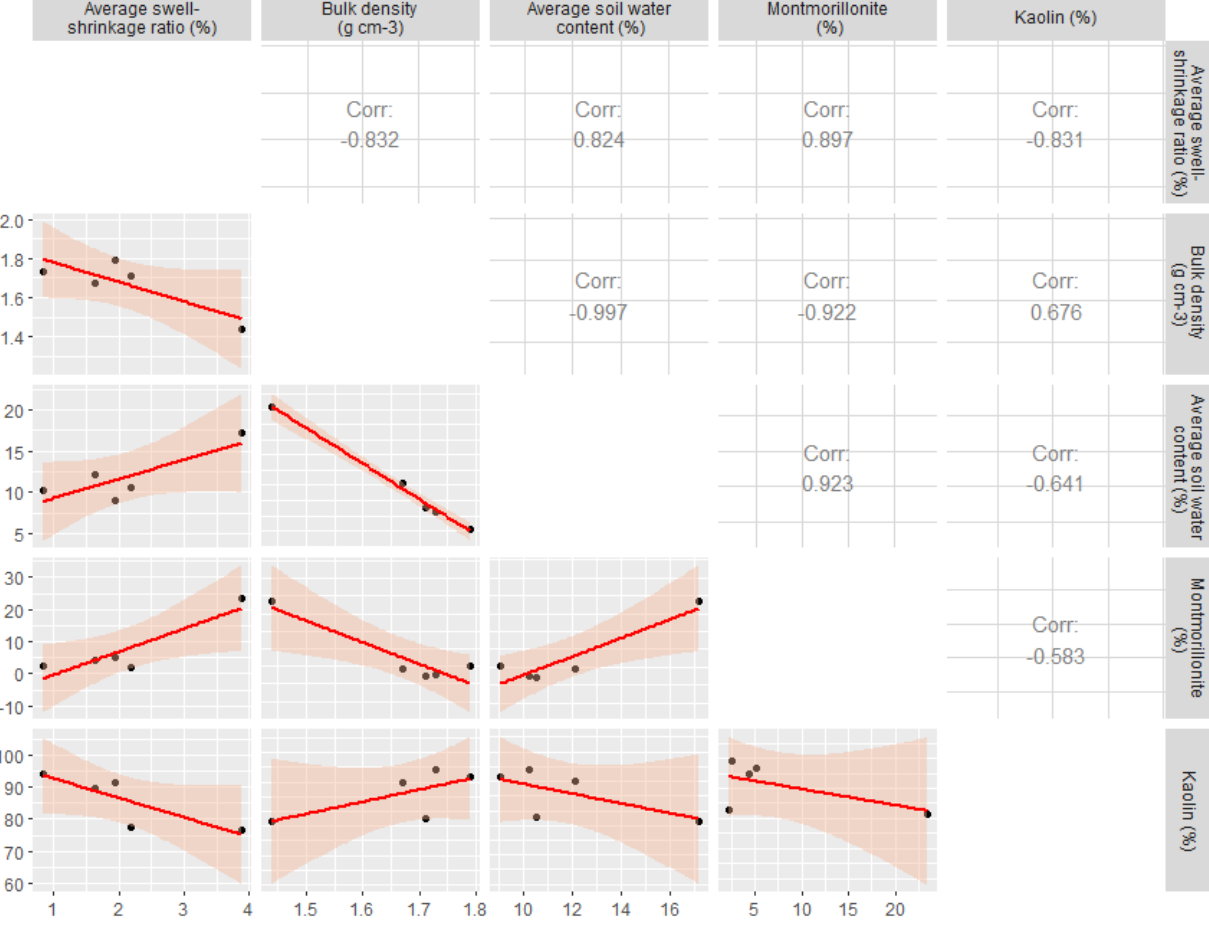
Figure 4. The correlation matrix among five good correlation indicators.